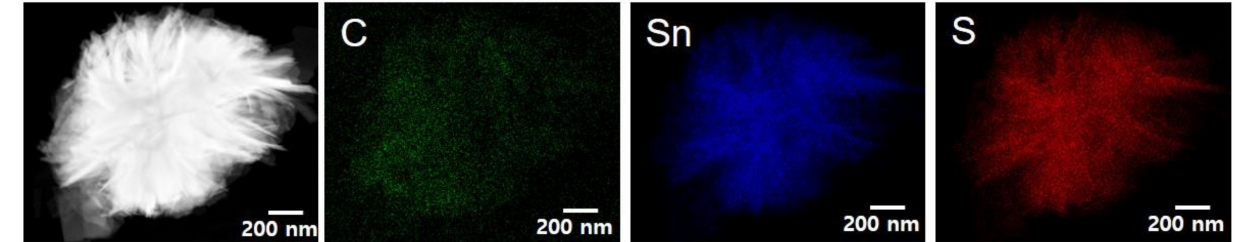
Figure 6. TEM elemental mapping images of the RGO/F-SnS NCs synthesized in this study.